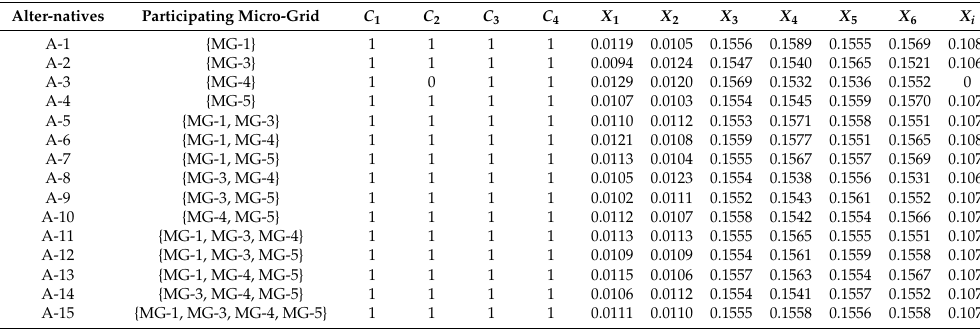
Table A1. The equally weighted arithmetic mean decision-making matrix for different aggregators. Alter-natives